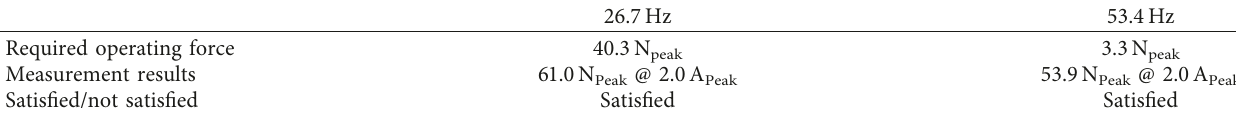
Table 8: Measurement results of blocking force compared with required force.